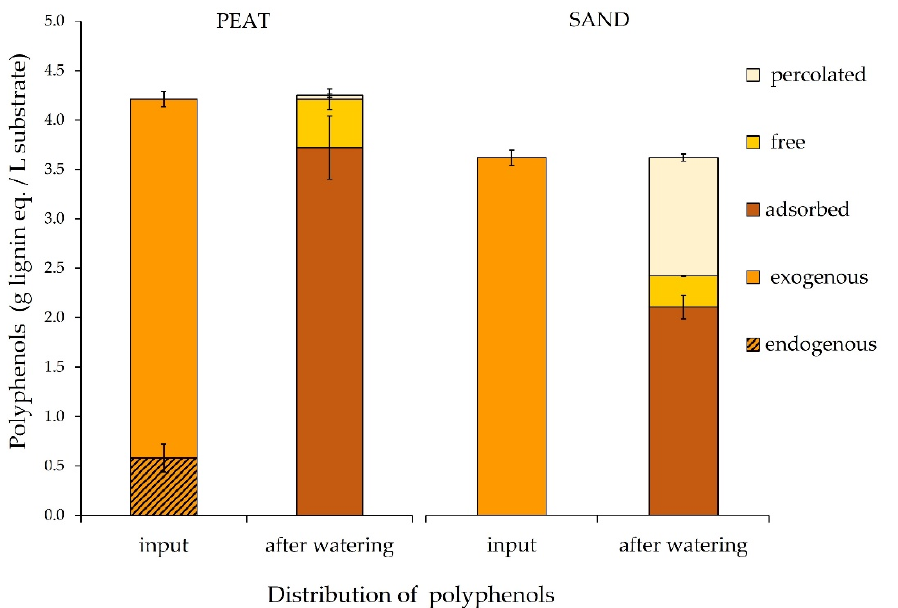
Figure 5. Distribution of lignin-derived polyphenols in peat and sand treated with undiluted giant reed extract in tray experiments. Columns represent the quantity of polyphenols in input (endoge- nously present in the substrate or exogenously added with the extract) and after watering (adsorbed into the substrate, free in solution, or percolated out of the tray). Bars represent standard deviation values ( n = 3).